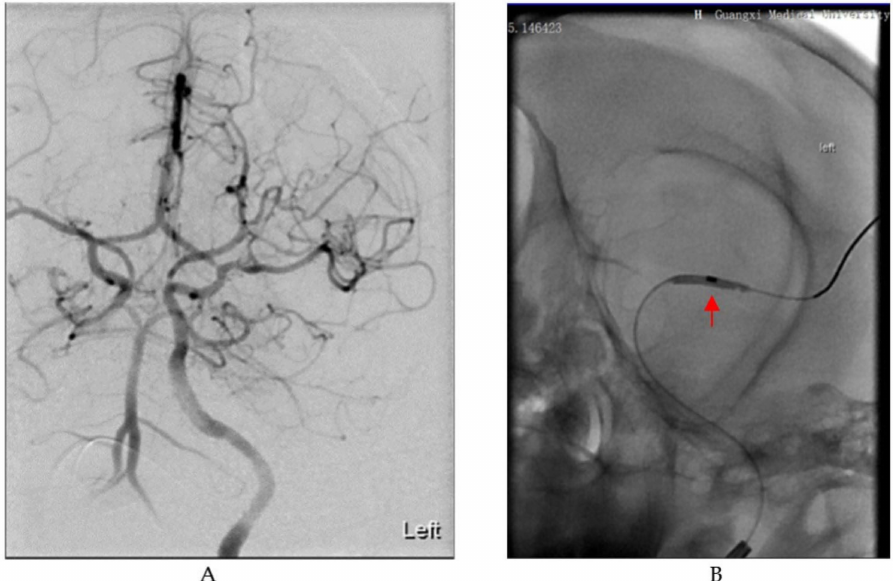
Figure 1. Digital subtraction angiography (DSA) images in the process of establishing the cynomolgus monkey stroke model. ( A ) Image of cerebral vascular anatomy in cynomolgus monkeys under DSA. ( B ) A balloon dilates in the M1 segment of the MCA as indicated by the red